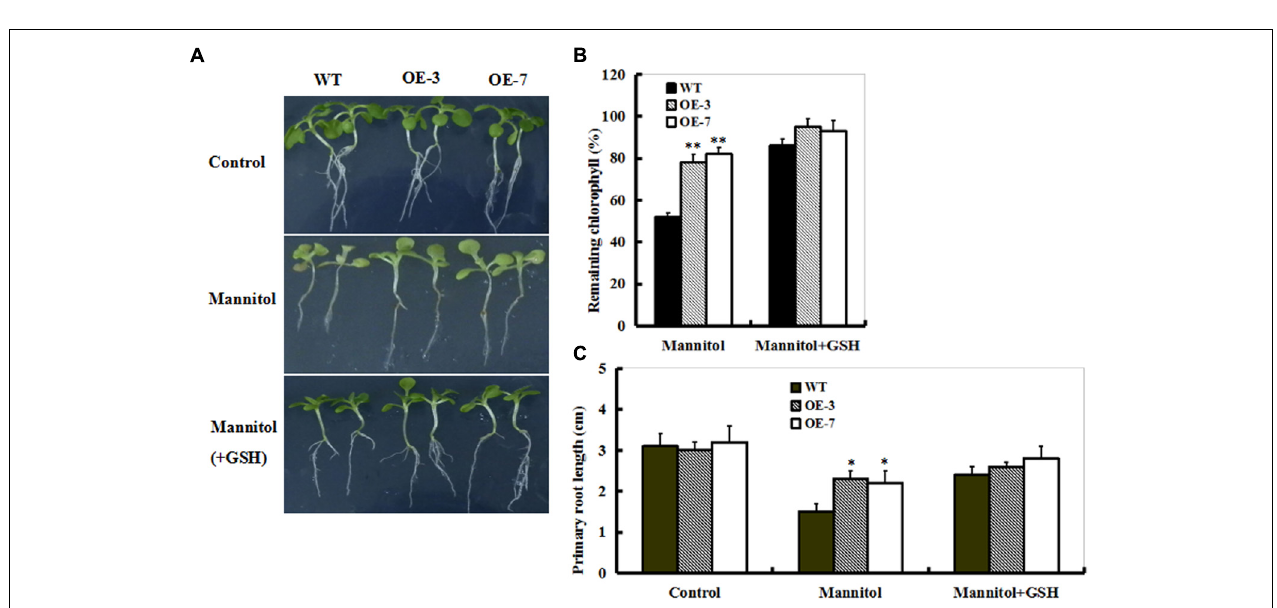
FIGURE 6 | Effect of exogenous GSH on response of WT and ZmSO -overexpressing plants to drought stress. (A) Representative growth phenotypes of WT and OE tobacco seedlings when exposed to mannitol and mannitol+GSH. Ten-day-old seedlings of WT and OE lines (OE-3 and OE-7) were vertically growing on 1/2 MS medium supplemented with 0 (Control), mannitol (300 mM), and mannitol (300 mM) plus GSH (10 mg/L) for 10 days. (B) Relative residual chlorophyll (%) in the WT and OE lines after mannitol and mannitol plus GSH treatments. Values are mean ± SE, n = 15. ∗∗ t -test, with P < 0.01. (C) Primary root length under mannitol treatment in (B) after 10 days. Values are mean ± SE, n = 15. ∗ t -test, with P < 0.01.